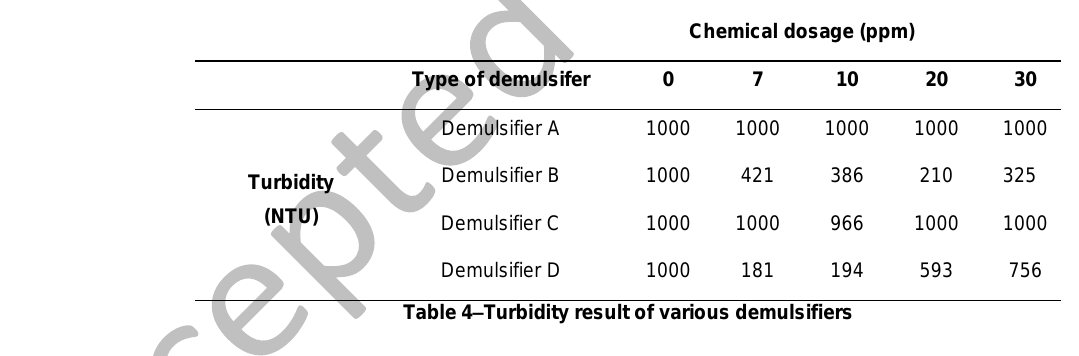
Table 4–Turbidity result of various